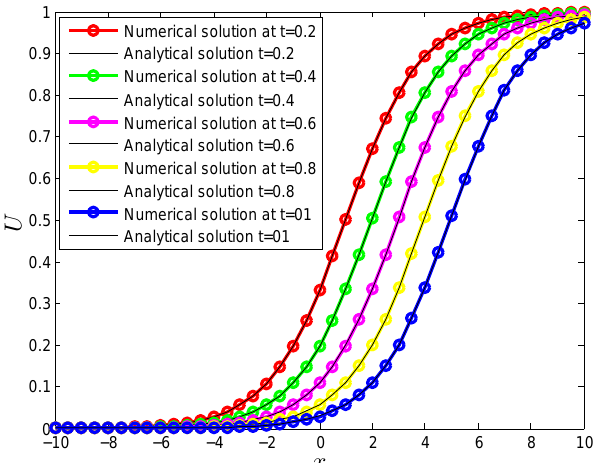
Figure 1. Comparing the curves of the numerical and analytical solutions for N = 41, q = 4 for Test Problem 6.